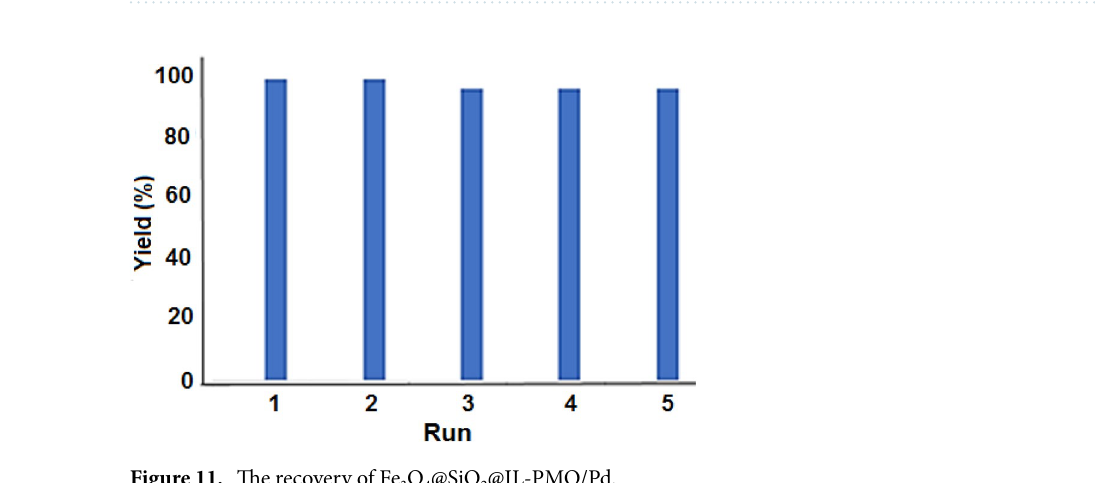
Table 2. Heck reaction of aryl halides and acrylates using Fe 3 O 4 @SiO 2 @IL-PMO/Pd catalyst.